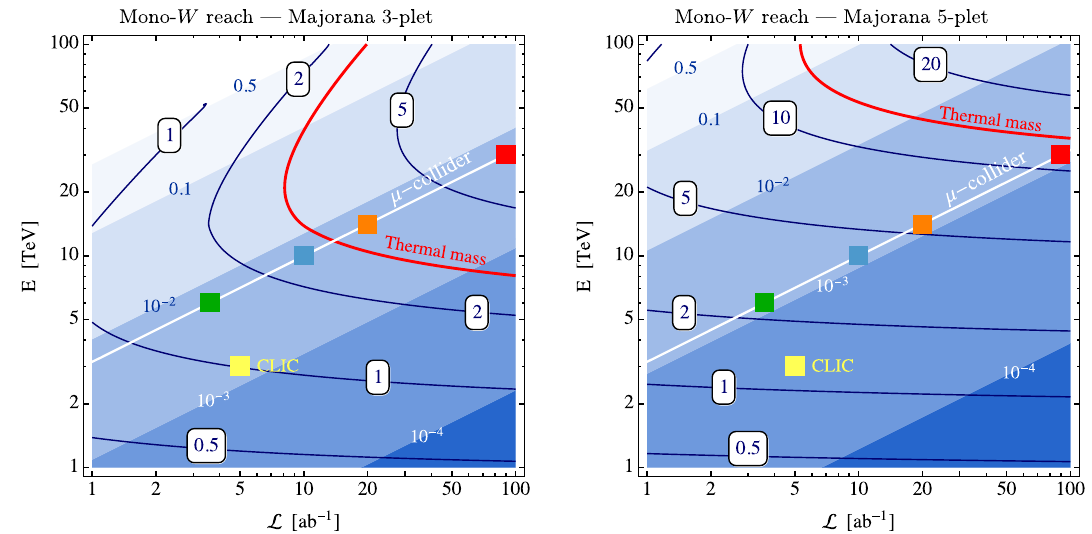
Fig. 4 Reach from mono- W searches at a muon collider, as a function √ s and integrated luminosity L . The of collider center-of-mass energy blue contours show the 95% C.L. reach on the WIMP mass; the pre- diction from thermal freeze-out is shown as a red line. The precision of the measurement is shown by the blue shadings. Systematic uncer-